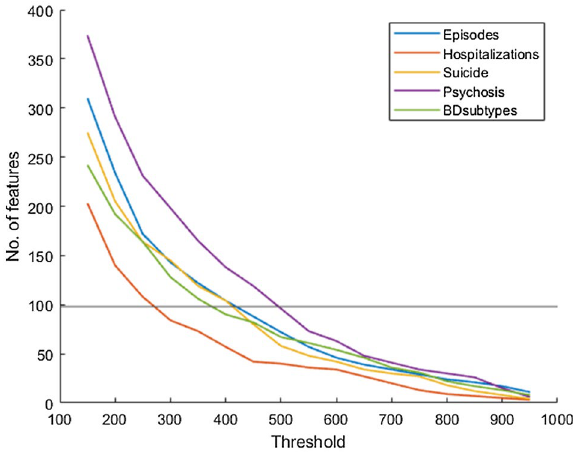
Figure 1. Number of features with different thresholds.